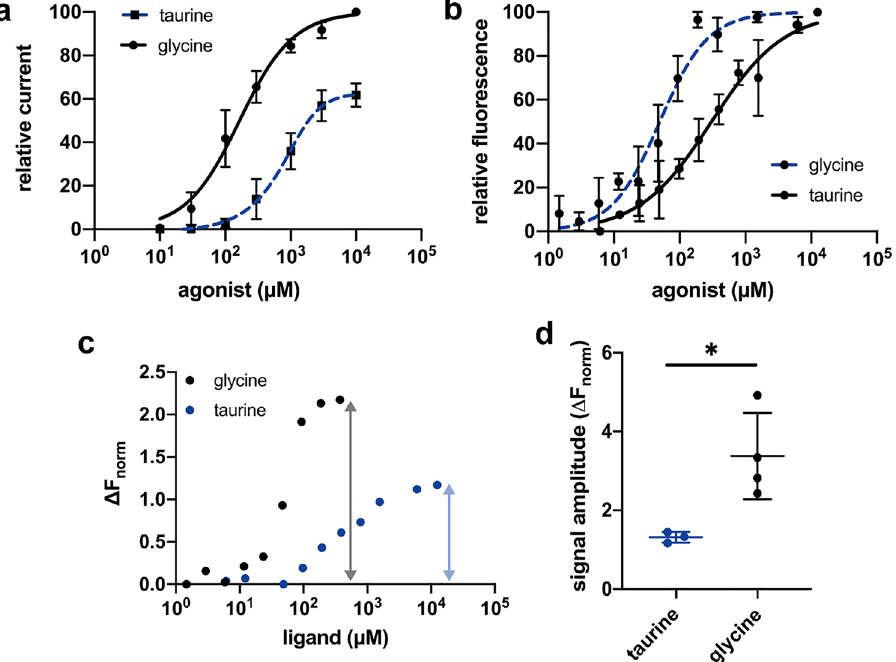
Figure 4. Binding characteristics of the partial agonist taurine to α1-GFP GlyR nanodiscs. ( a ) Dose–response data for glycine and taurine of heterologous expressed α1 GlyR from X. laevis oocytes. Taurine acts as a partial agonist with an aEC 50 value of 843 ± 16 µM reaching a maximum current of 61% compared to glycine ( n = 3). Taurine currents are normalized to the maximum glycine currents for each cell. Dose–response data of glycine are the same as shown in Fig. 3. Error bars represent SEM. ( b ) MST binding experiment of α1-GFP GlyR with a taurine titration series of 6 µM to 12.5 mM results in a cEC 50 value of 473.8 ± 46.1 µM ( n = 3). Error bars represent SEM. ( c ) Exemplary α1-GFP GlyR MST data of taurine (blue circles) and glycine (black circles) obtained from oocytes displaying a difference in their maximal thermophoretic mobility (grey and blue arrows). ( d ) Comparison of the signal amplitudes of α1-GFP GlyR SMALPs expressed in HEK293 cells and oocytes for glycine and taurine. Binding of taurine leads to a significant decreased thermophoretic movement ( p = 0.024, unpaired two-side t test, n = 3) with signal amplitudes of 1.32 ± 0.14 compared to glycine-bound receptors with signal amplitudes of 3.38 ± 1.09. Data are shown in mean ±